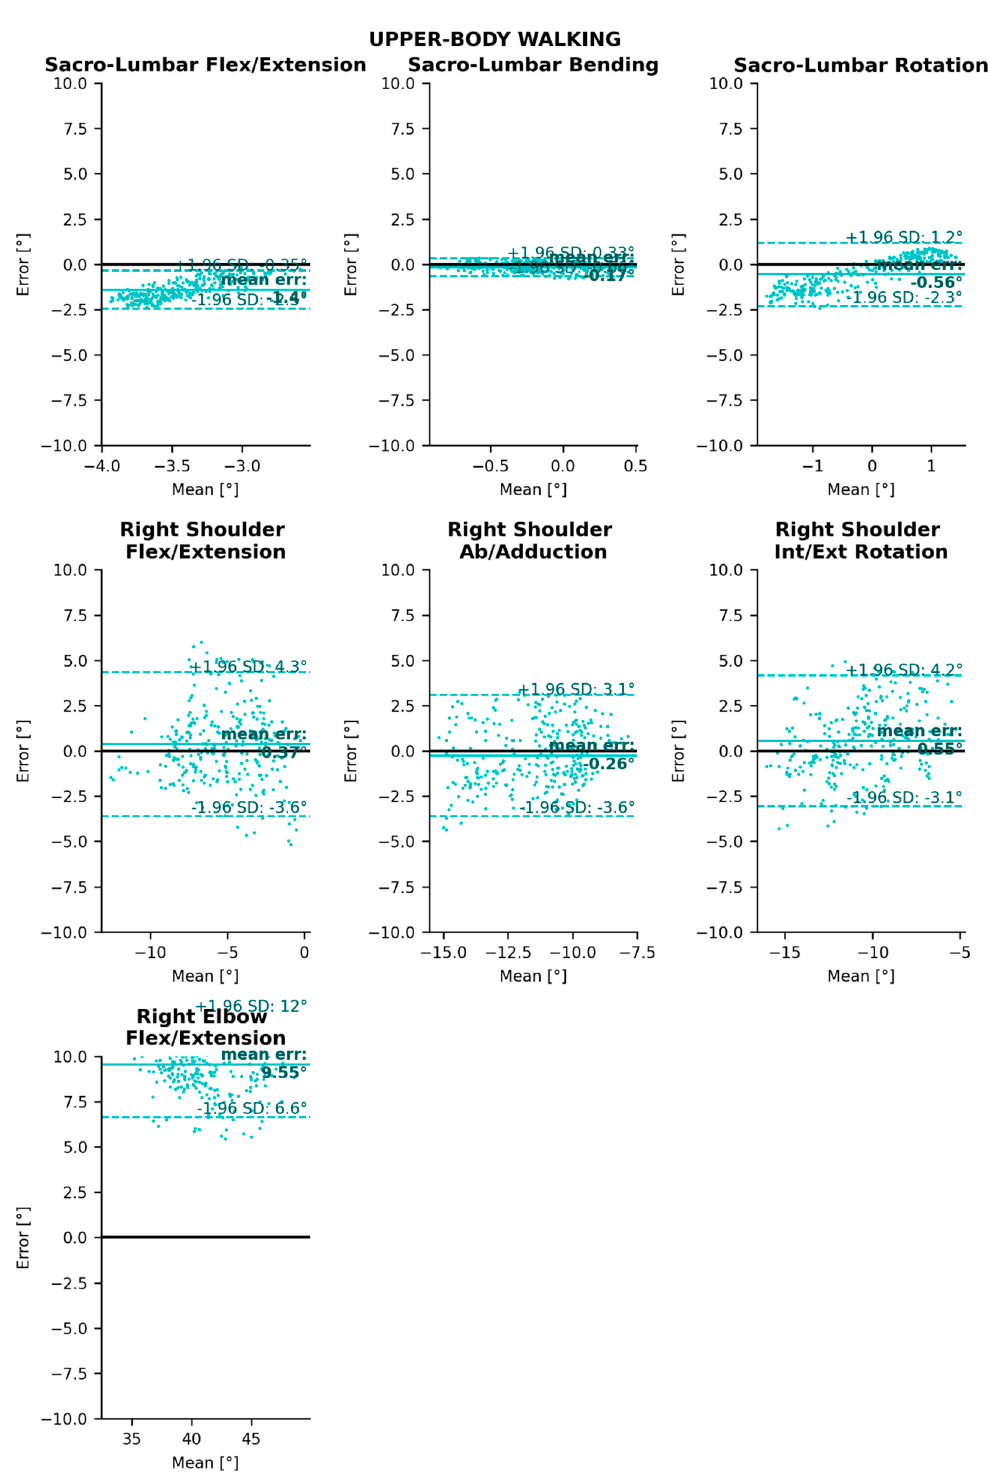
Figure A2. Bland–Altman analysis of sacro-lumbar and upper-body joint angle errors for the walking task. Mean bias is represented as a horizontal solid, bold line, and 95% limits of agreement are represented as dotted lines.